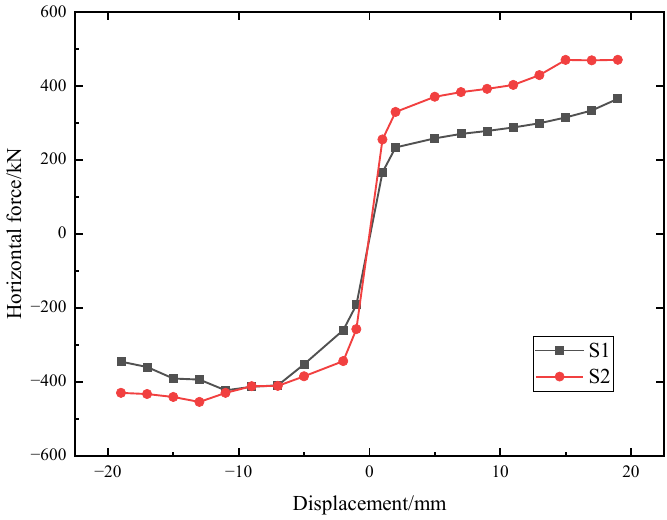
Figure 10. Load-displacement hysteretic curves of the specimens. ( a ) S1; ( b ) S2.